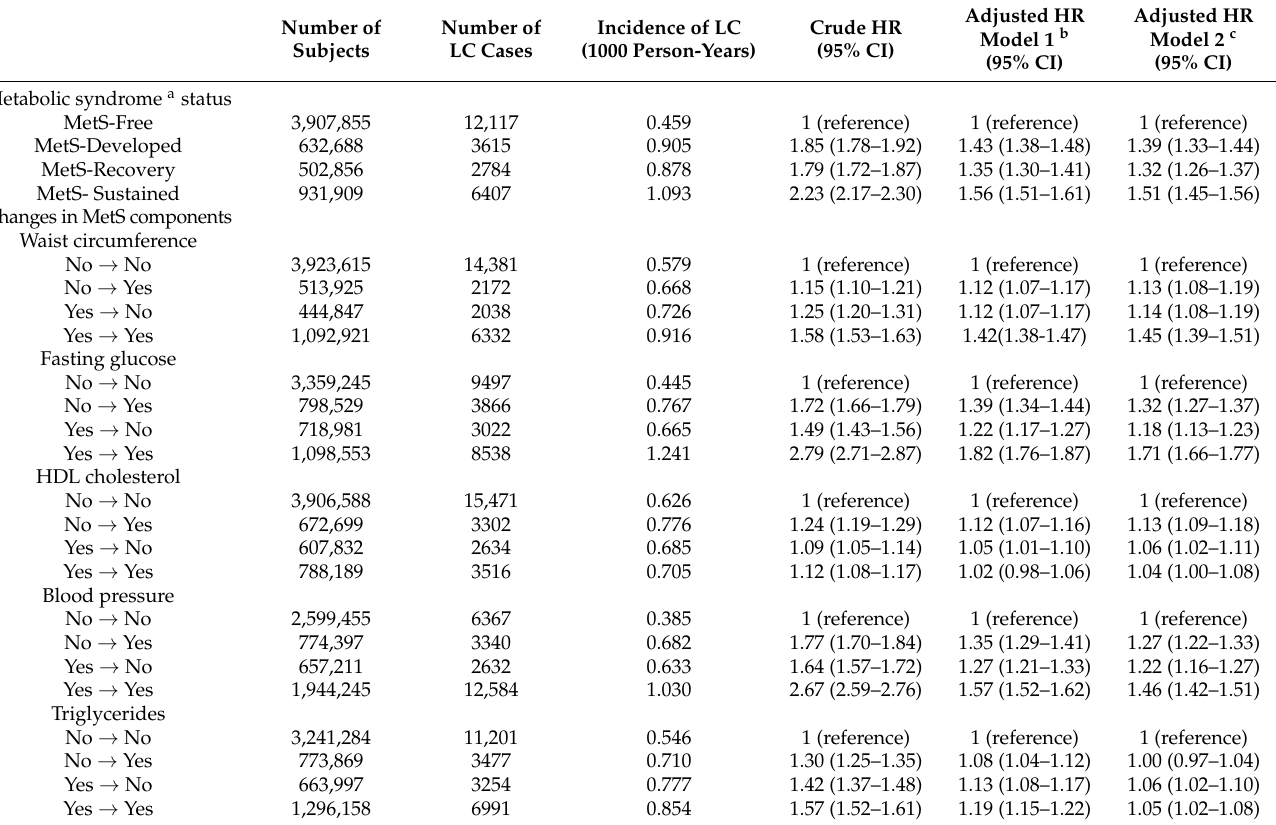
Table 3. Incidence of liver cirrhosis according to metabolic change during two years of follow-up. Number of Subjects